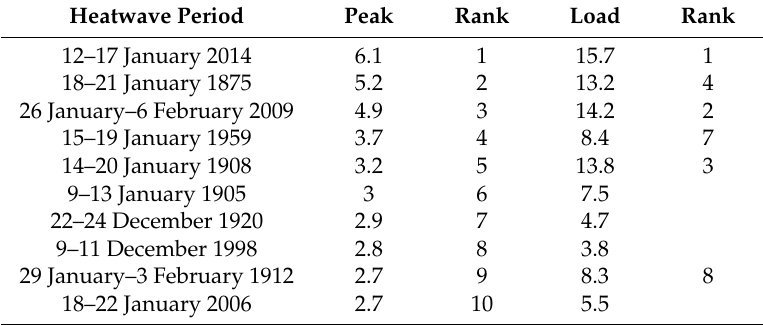
Table 3. Heatwave event peak and load using severity for Melbourne (1855 to 2018). Top 10 ranked for event peak severity. Severity is dimensionless [].